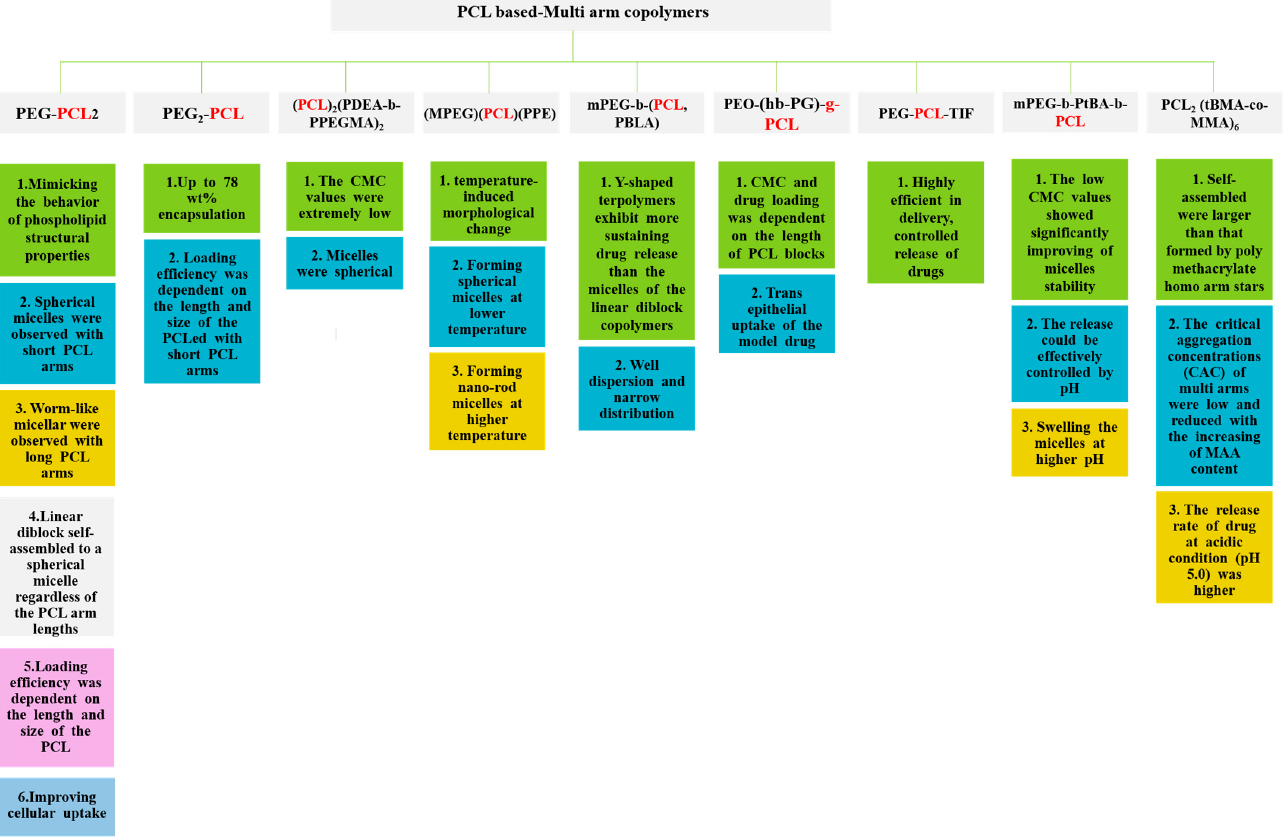
Figure 16. Ability of multi-arm architectures to respond to the various requirements of the drug delivery.